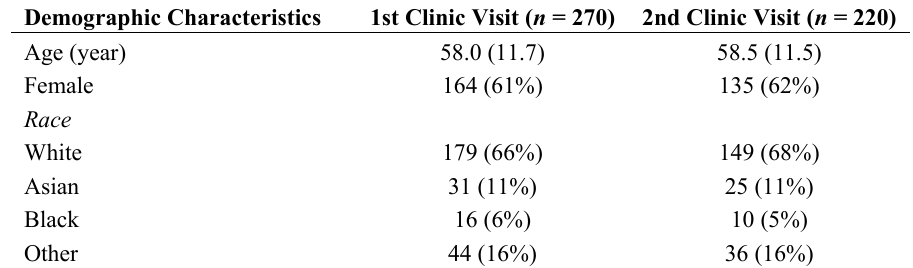
Figure 1. Flowchart of clinic visit 1 and 2. Table 1. Demographic characteristics of CAFEH participants who participated in at least one clinic